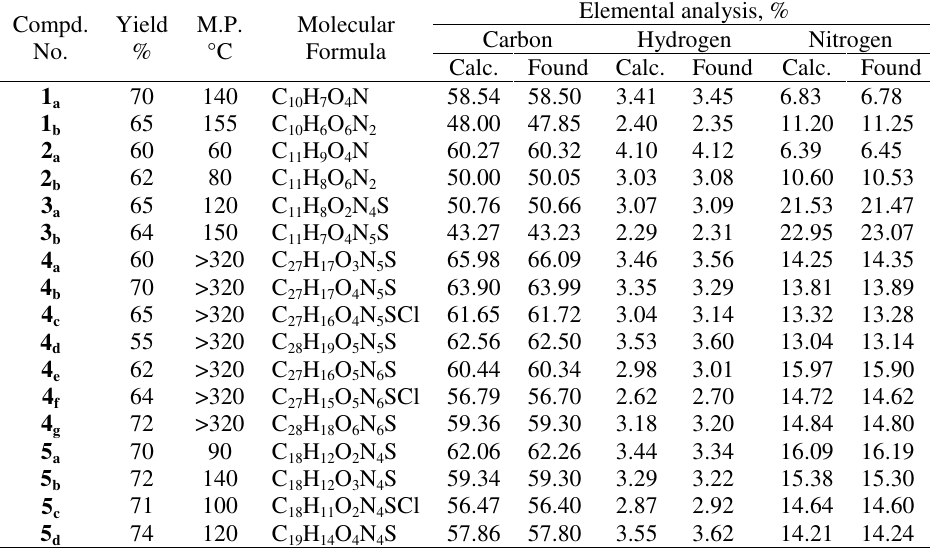
Table 2. Antibacterial activity of compounds (4